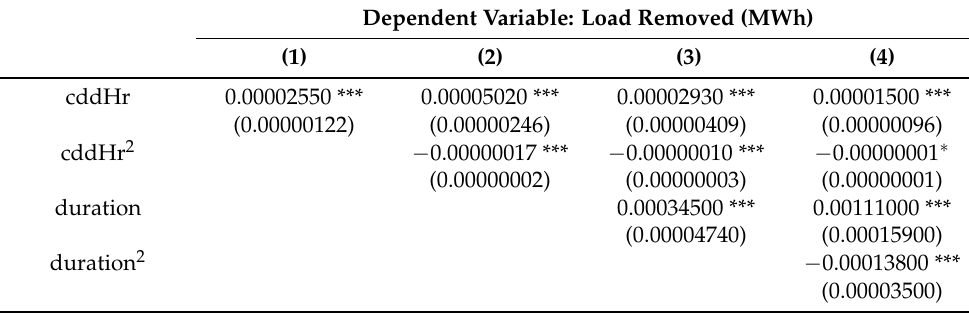
Table 4. Load-recovered–panel fixed effects with clustered standard errors